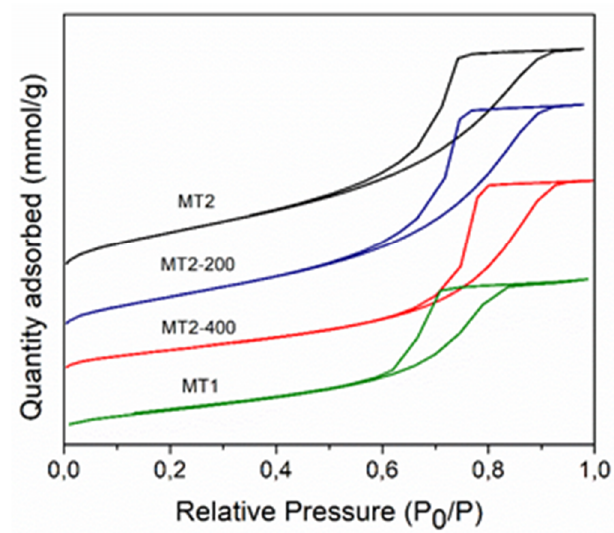
Figure 3. N 2 adsorption / desorption isotherms for material (MT1) and all MT2 samples.